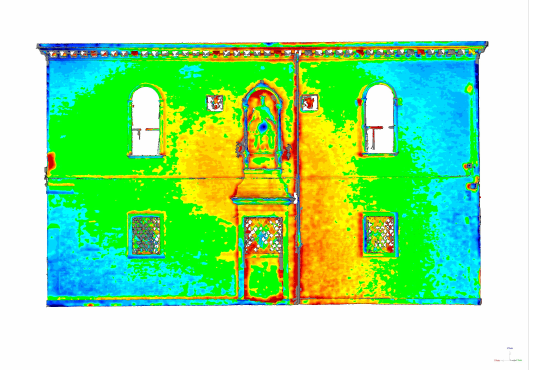
Figure 9. Results of 3d compare of the School of